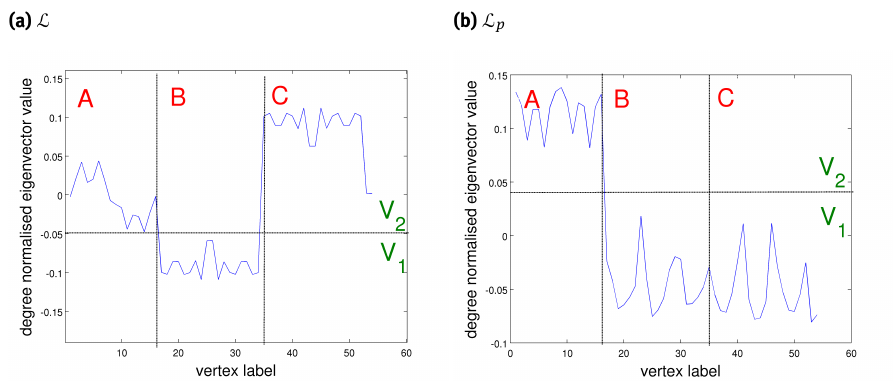
Figure 4: Plots of f 2 = N −1 g 2 , where g 2 is the second eigenvector of either L or L p for the Ellingham-Horton 54-graph. (a) f 2 from the static Laplacian L . (b) f 2 from the dynamic Laplacian L p . The letters “A”, “B”, “C” and the vertical lines refer to the static community structures labelled in Figure 3. The horizontal line indicates the optimal value of γ used for selecting V 1 , V 2